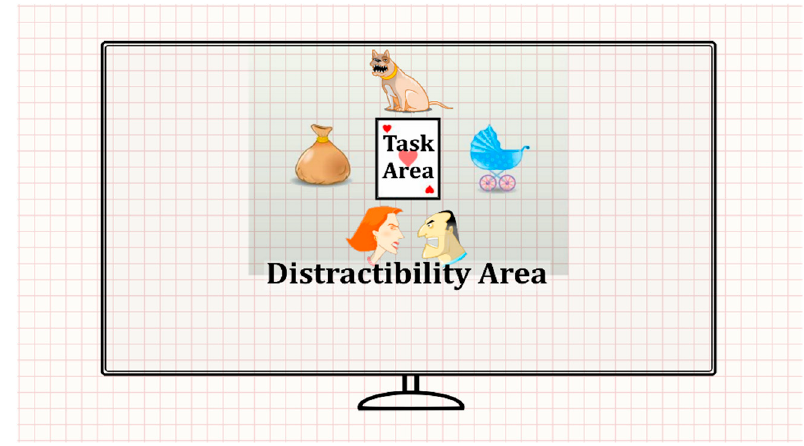
Figure 1. Participant field of view (FOV) while performing the MOXO-dCPT, divided into distractibility (gridded) and target areas of interest (AOIs).